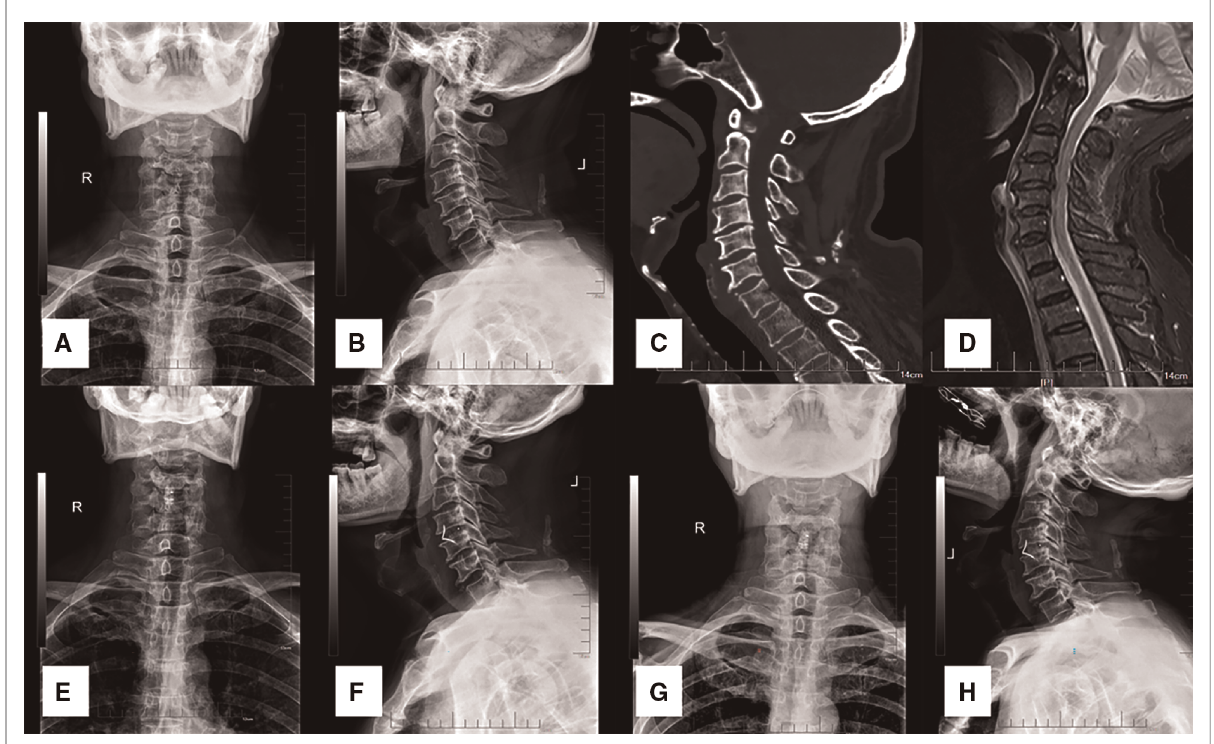
FIGURE 1 A 60-year-old male patient diagnosed with TCCS. ( A,B ) preoperative A-P and lateral x-ray showing the slight degenerative change of cervical spine with relative normal curvature, and conspicuous anterior osteophyte formation. ( C ) preoperative CT scan demonstrated no fracture or dislocation of the cervical spine. ( D ) preoperative MRI from short time inversion recovery (STIR) illustrated signi fi cant cervical spinal cord compression at C4 – 5 with spinal cord signal change at the same level, while evident prevertebral hyperintense and slight elevation of the ligament was also detected. ( E,F ) postoperative A-P and lateral x-ray at discharge indicate well positioned ROI-C device with normal CA and disc height. ( G,H ) the CA and disc height remained at fi nal follow-up, and solid fusion was